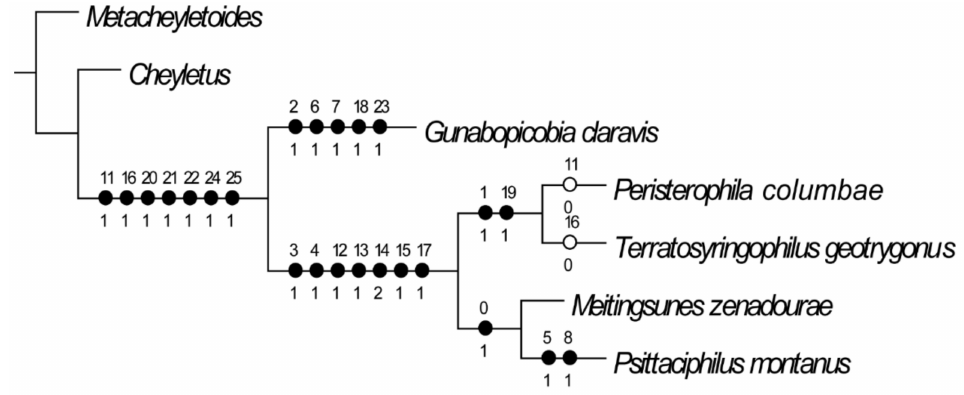
Figure 3. Phylogenetic tree of selected genera of Syringophilidae mites associated with Columbiformes